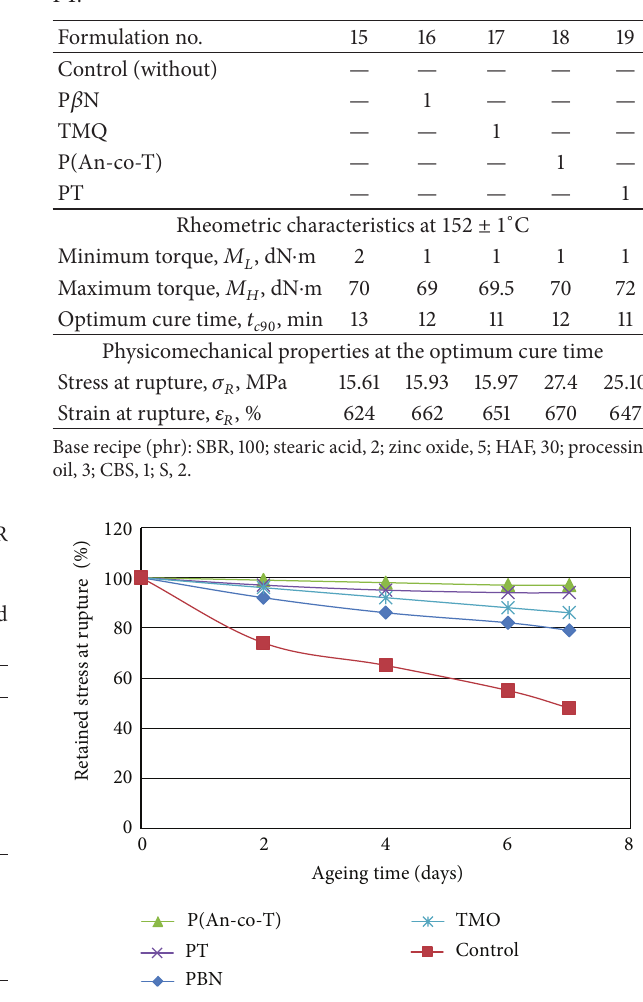
Figure 7: Retained stress at rupture versus ageing time for NR